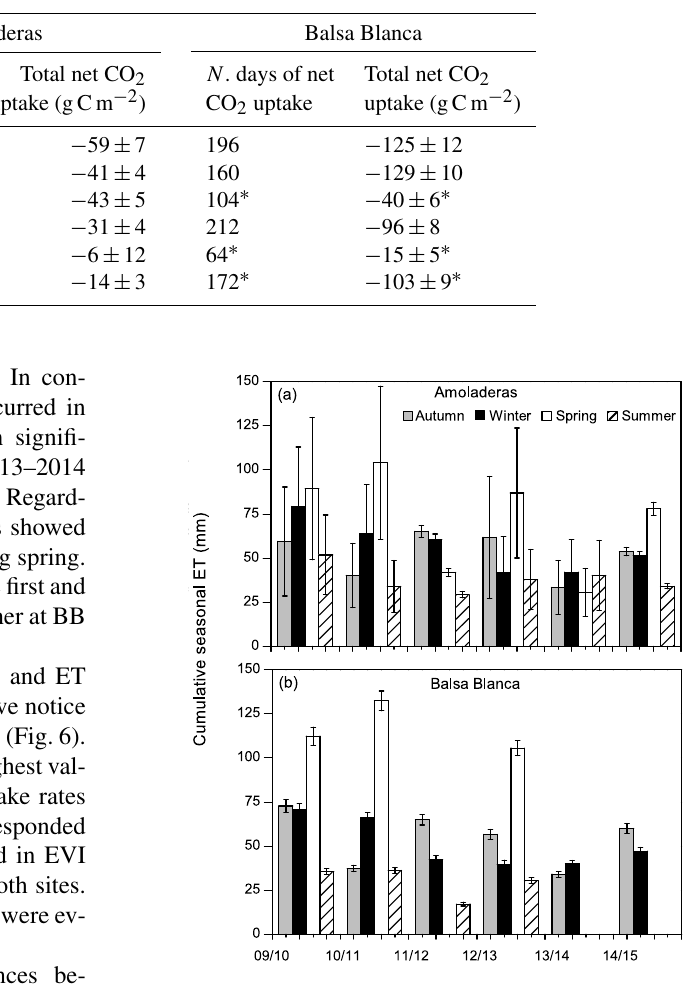
Figure 5. Cumulative seasonal evapotranspiration fluxes (ET) over the study period at both experimental sites. In the case of Balsa Blanca, missing bars correspond to long-term data losses ( > 50% data). Error bars denote uncertainty derived from the gap-filling pro-